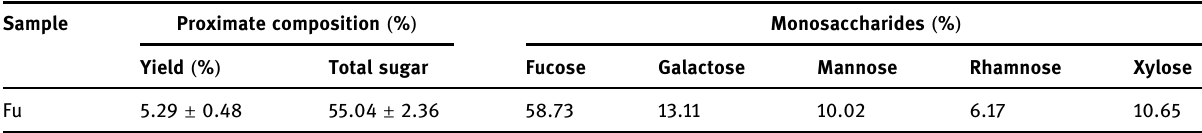
Table 2: Total yield, proximate composition, and monosaccharide composition of Fu isolated from C. barbata Sample